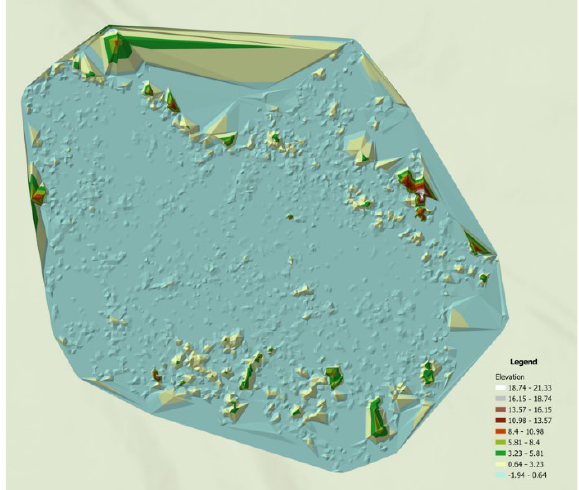
Figure 8: Normalized point cloud converted to